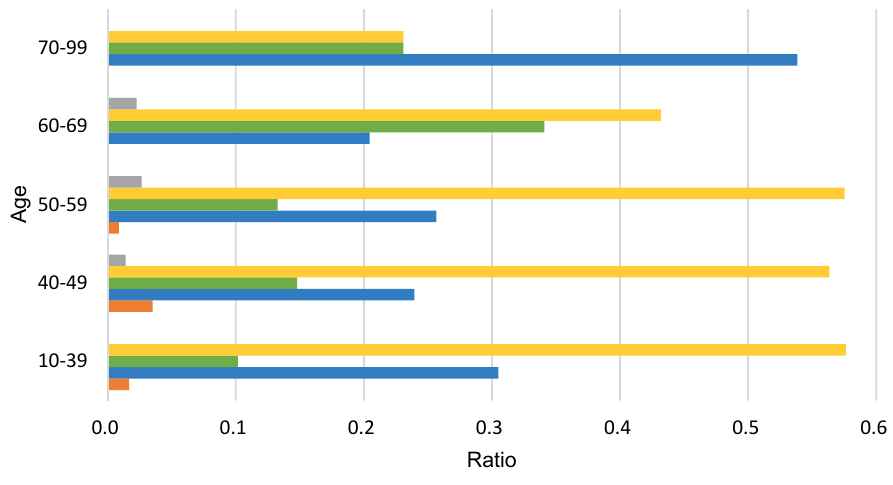
Figure 1. The distribution of mental disorders by age group. The frequency density by disease also peaked within 2 months after diagnosis. There was a difference in the peak times of the mental disorders. The overall frequency density of mental disorders increased from 12 months before the diagnosis of breast cancer to 2 months after diagnosis (Figure 2). The frequency density changed rapidly before and after cancer diagnosis. The increase in frequency density for mental disorders was higher in patients aged around 60 years than in the other age groups.